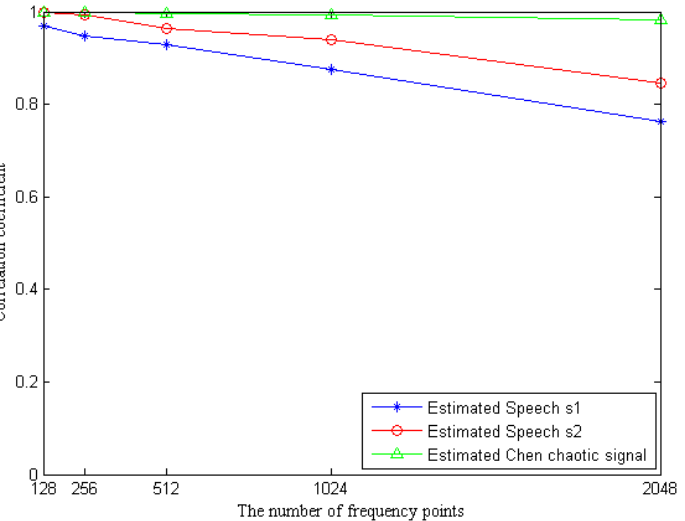
Figure 6. The relationship between frequency points and correlation